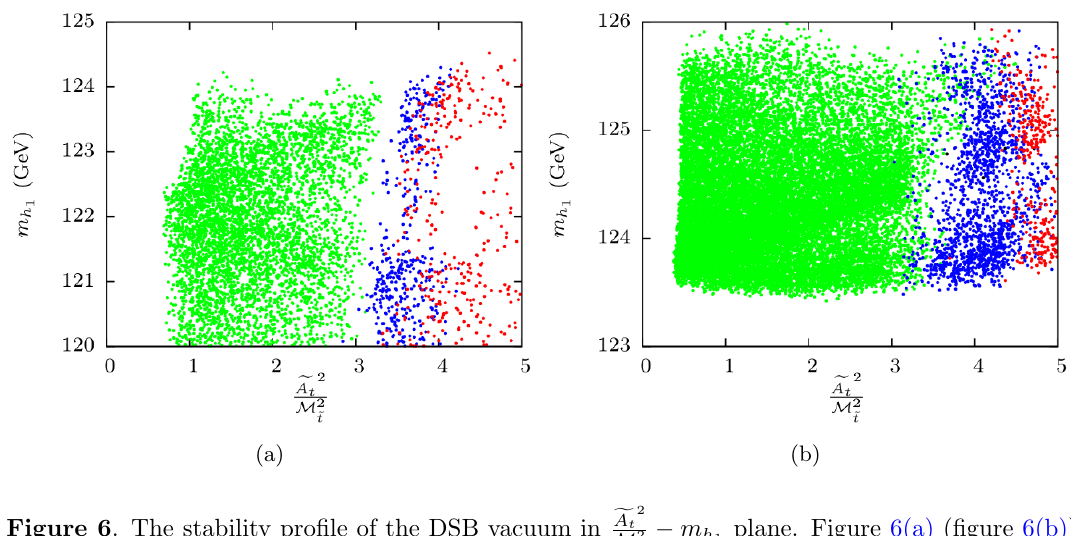
Figure 6 . The stability pro(cid:12)le of the DSB vacuum in f A t refers to 5 (cid:20) tan (cid:12) (cid:20) 10 (40 (cid:20) tan (cid:12) (cid:20) 50). The color codes are same as that for (cid:12)gure